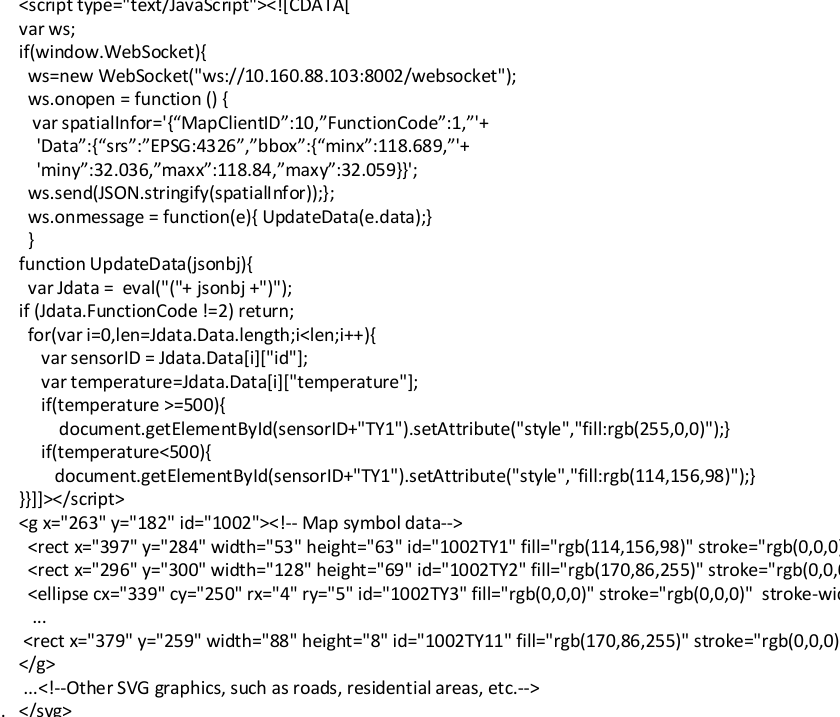
Figure 9. SVG map instance for real-time visualization based on map symbol and mapping profile.